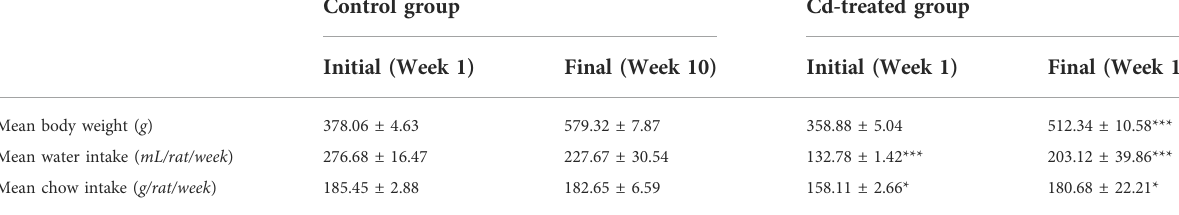
TABLE 1 Body weight, water intake and chow intake during the period of the study.